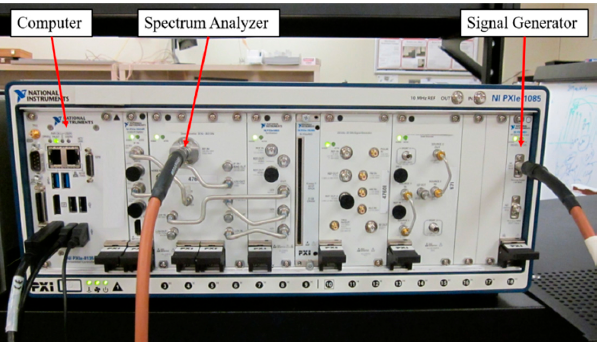
Figure 10. Photographs of the NI chassis with computer, signal generator, and spectrum analyzer.